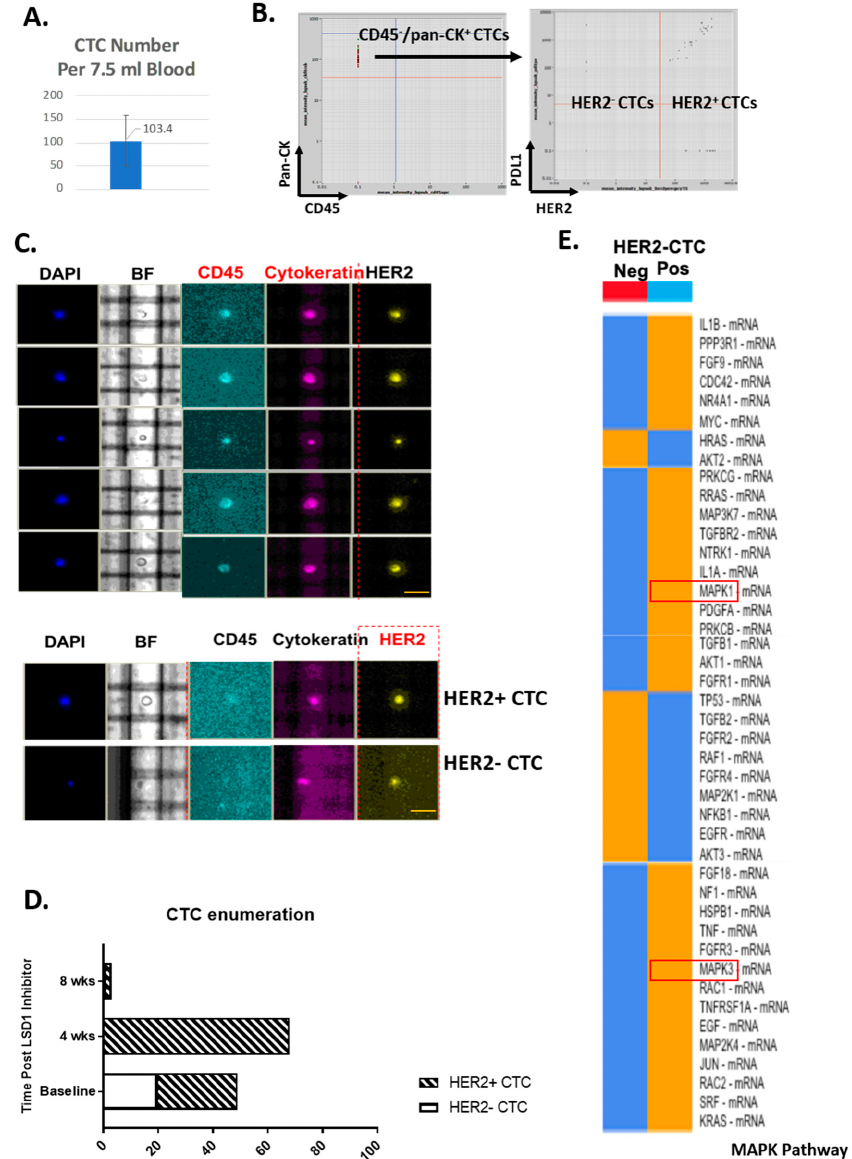
Figure 1. HER2-positive and negative circulating tumor cells (CTCs) have distinct mRNA profiles in metastatic triple negative breast cancer (TNBC) patients. CD45-negative enriched PBMCs were labelled with anti-human CD45-APC and pan-cytokeratin-FITC for DEPArray CTC enumeration and isolation. ( A ) CTCs were detected in metastatic TNBC patients. CTCs were enumerated in five metastatic TNBC patients using the DEPArray platform. Data represent the mean of CTC counts ± standard deviation in 7.5 mL equivalent whole blood. ( B ) Identification and isolation of HER2-positive and negative CTCs in the same patients. Plot shows the gating strategy for identifying HER2-